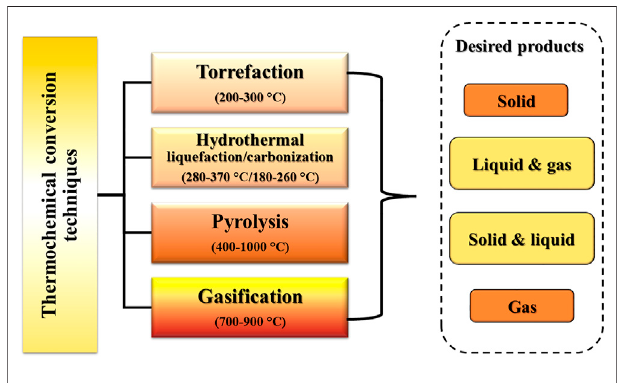
FIGURE 4 | Thermochemical conversion techniques and desired